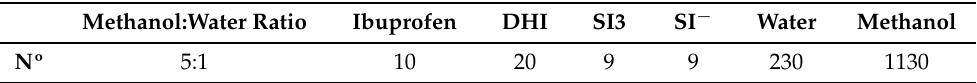
Table 2. Composition of the simulated